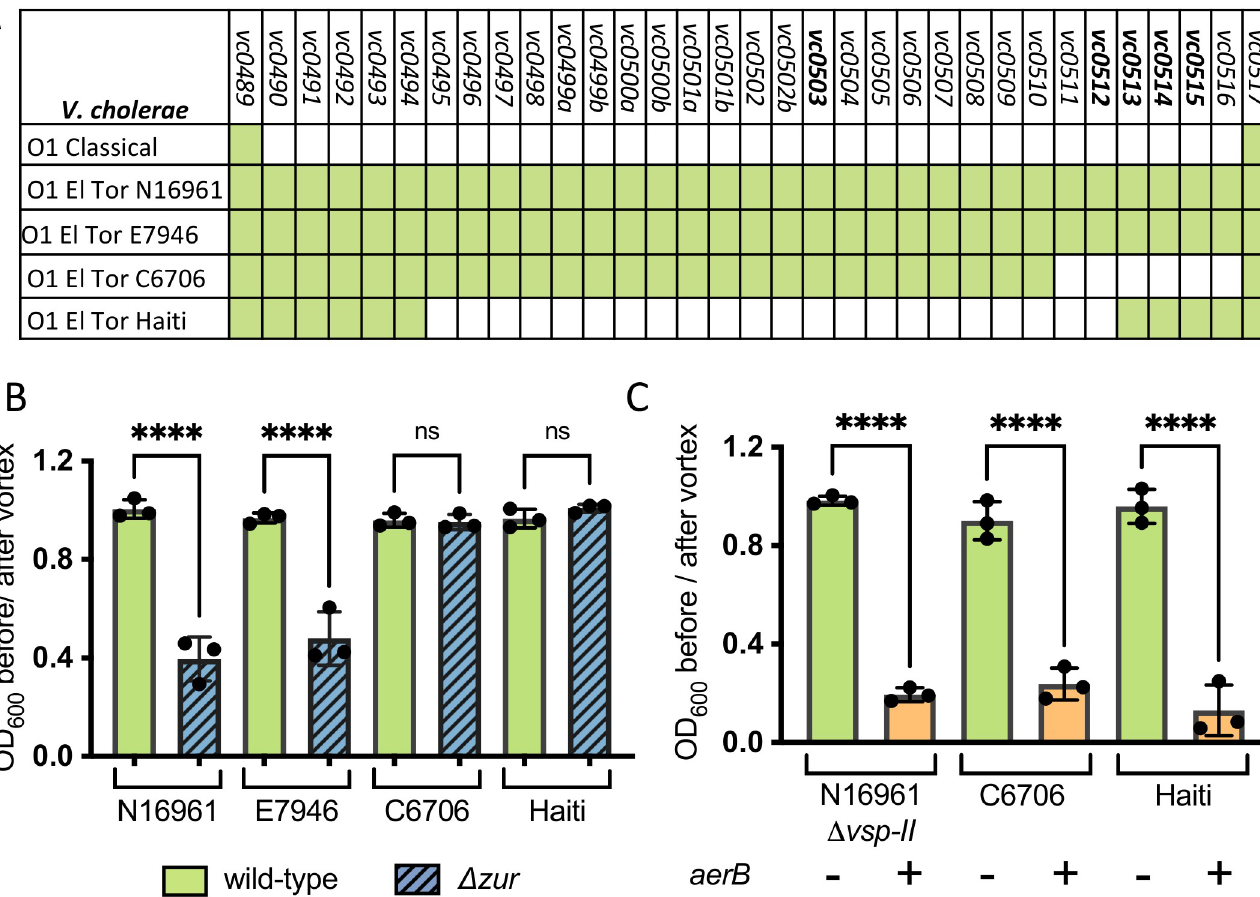
Fig 6. Ectopic AerB expression causes atypical El Tor strains to congregate. ( A ) Presence (green) or absence (white) of VSP-II open reading frames in V . cholerae strains with prototypical (N16961, E7946) and variant (Haiti, C6706) VSP-II islands are shown. (B ) Wild-type or Δ zur varieties of V . cholerae (N16961, E7946, C6706, Haiti) were grown overnight (~15 hr) shaking at 30˚C in M9 minimal medium with glucose (0.2%). Congregation was quantified by measuring the optical density (at 600 nm) of the culture supernatant before and after a brief vortex. ( C ) V . cholerae strains with (+) or without (-) an IPTG-inducible, chromosomal copy of aerB were grown as described in B but with the addition of IPTG (10 uM). For all bar graphs, raw data points represent biological replicates, error bars represent standard deviation, and asterisks denote statistical difference via Ordinary one-way ANOVA ( ���� , p < 0.0001; n.s., not significant).